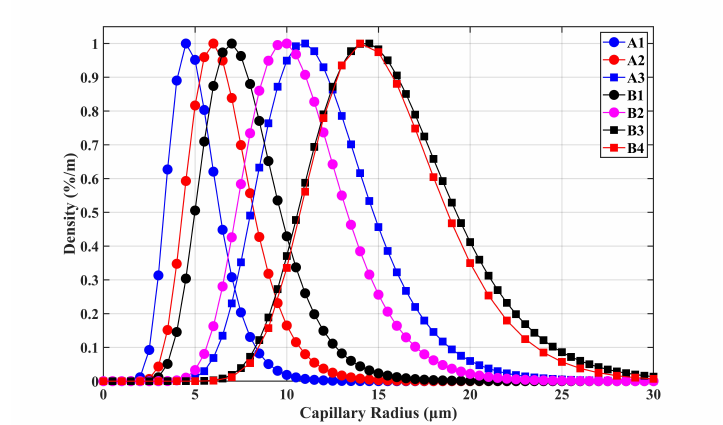
Figure 6. The CRDs of seven types of